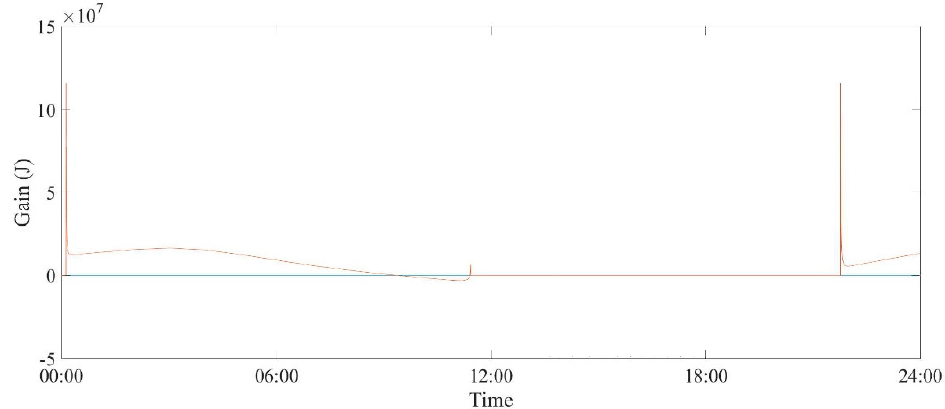
Figure 12. Energy use by Artificial Neural Network (ANN) at a normal condition.